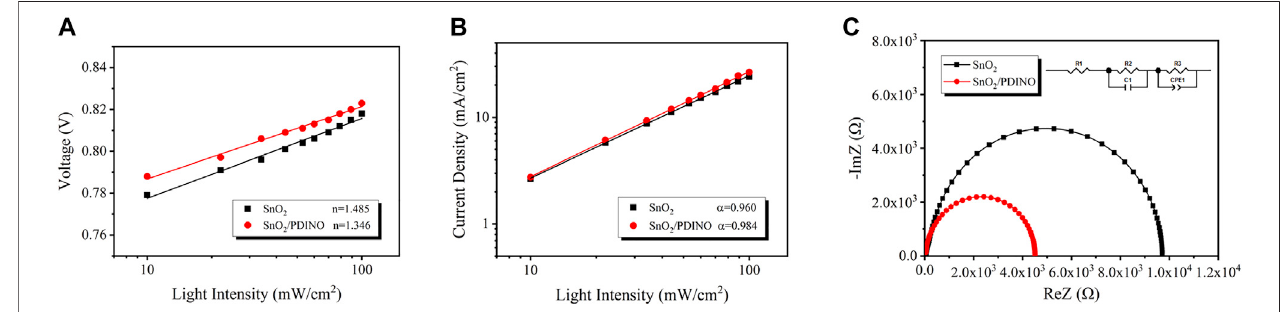
FIGURE 7 | (A) V OC dependence on incident light intensity of the OSCs. (B) J SC dependence on incident light intensity of the OSCs. (C) Impedance spectra of the OSCs. An inset of the transmission line model equivalent circuit is in the upper right corner.